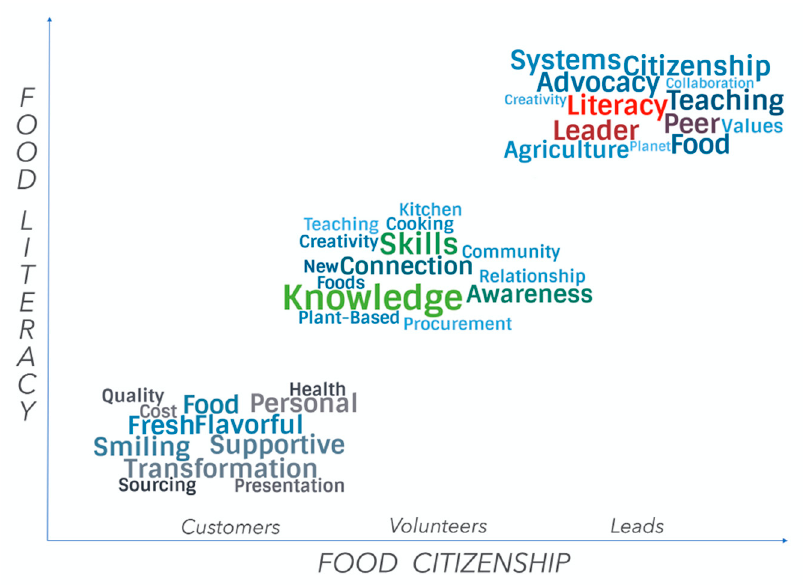
Figure 3. Themes and subthemes for customers, volunteers, and